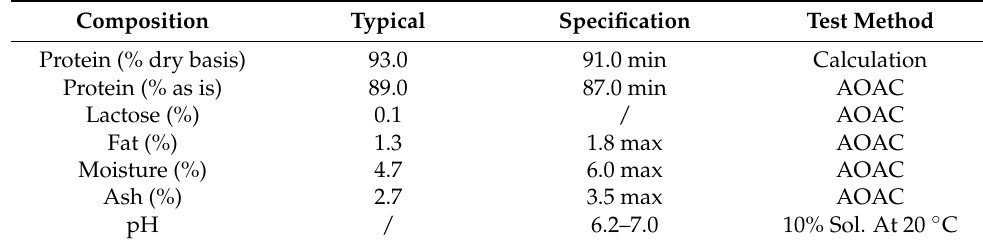
Table 1. Components and properties of whey protein. Composition Typical Specification Test Method Protein (% dry basis) 93.0 91.0 min Calculation